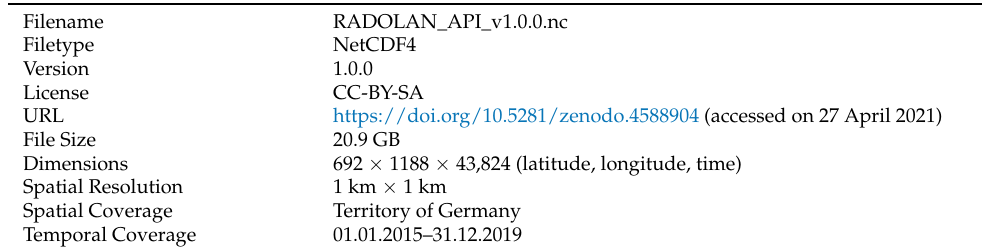
Table A1. RADOLAN_API data set description.